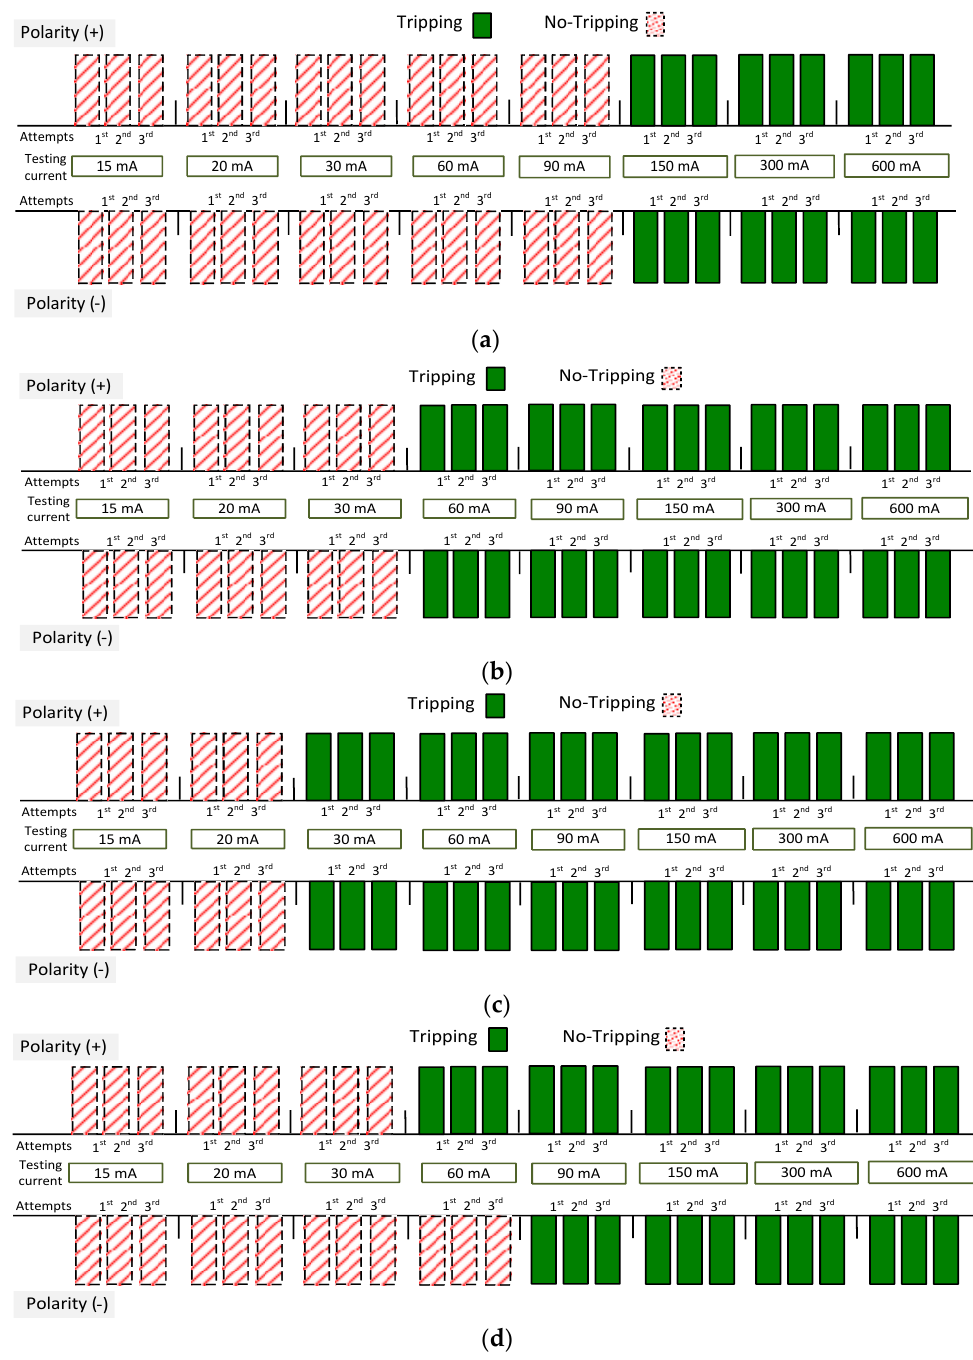
Figure 21. Tripping of the 30 mA A-type RCDs for a pure direct current (suddenly applied) of values 15, 20, 30, 60, 90, 150, 300 and 600 mA. Tested RCDs: ( a ) (RCD30_6); ( b ) (RCD30_7); ( c ) (RCD30_1); ( d ) (RCD30_8).